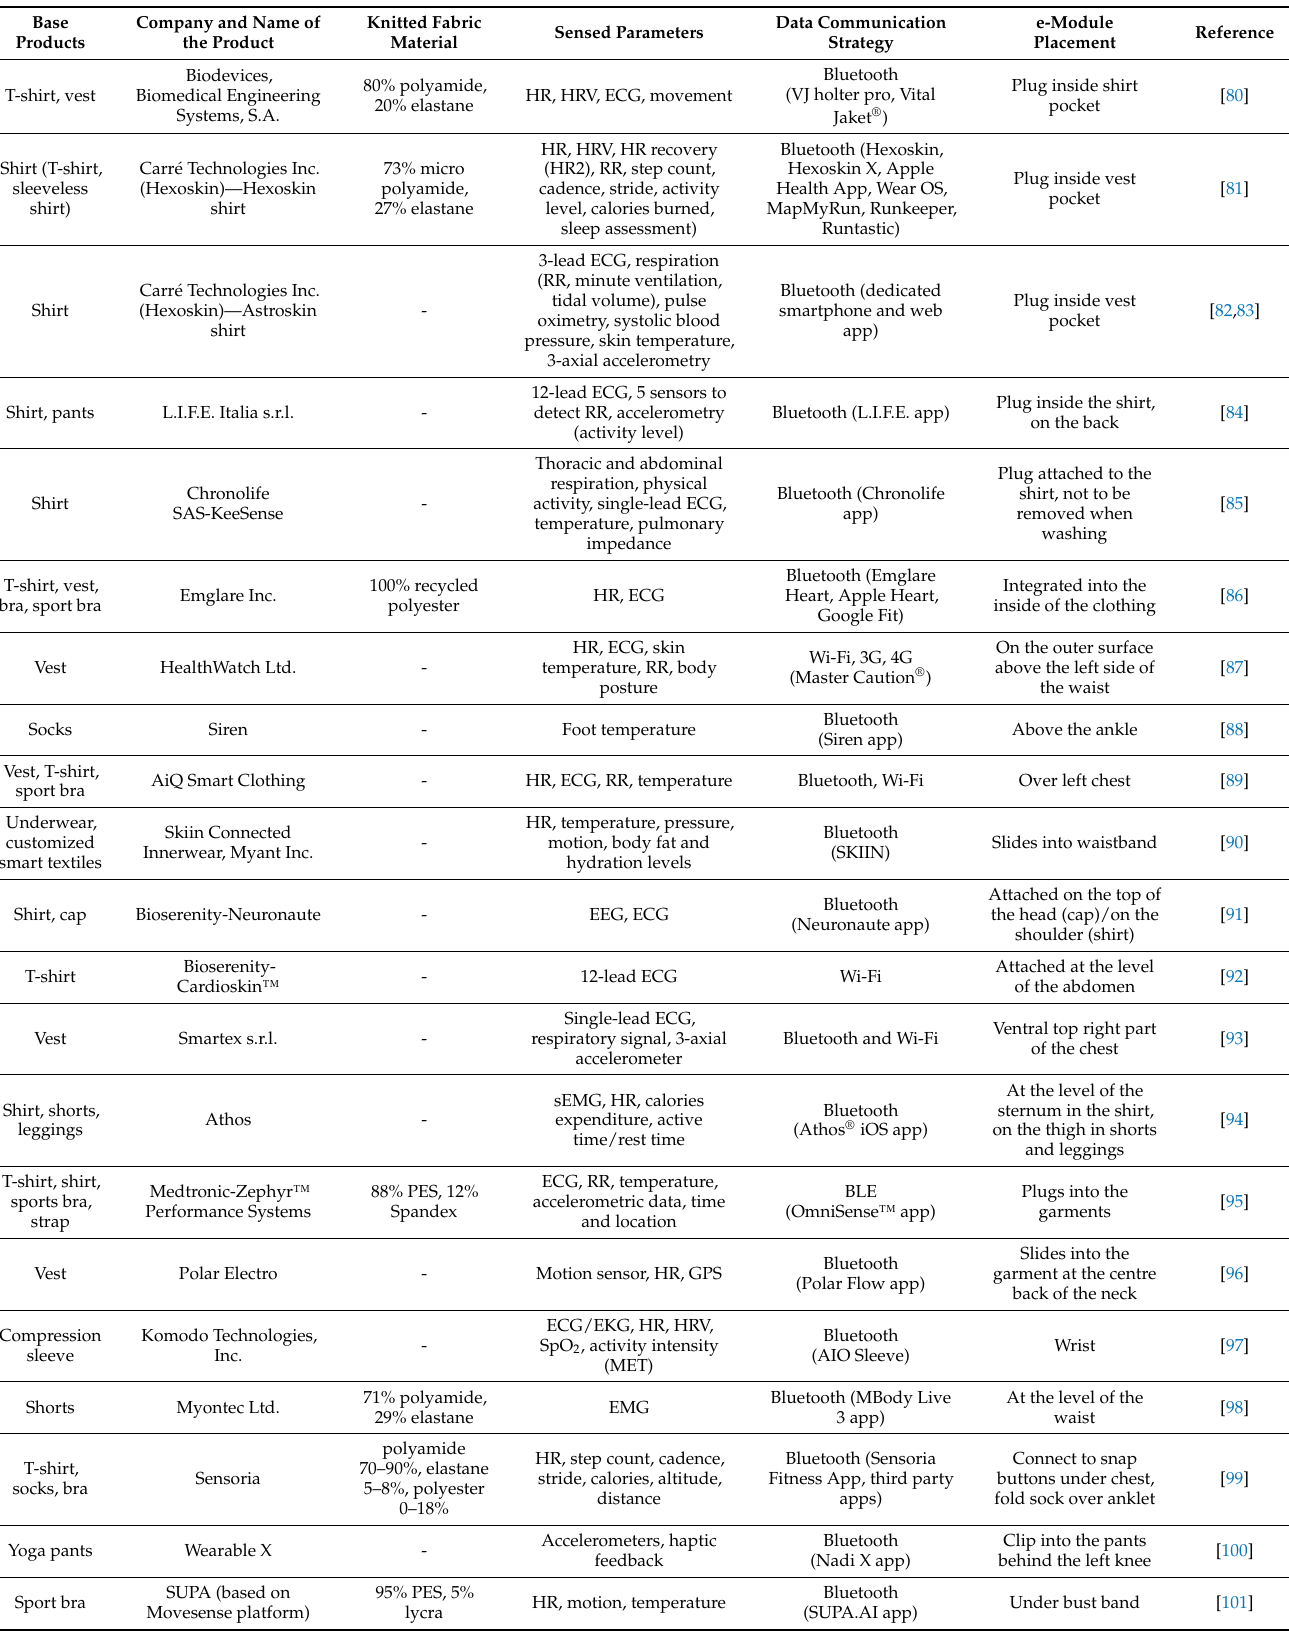
Table 4. Overview of some garments available on the market or in research settings